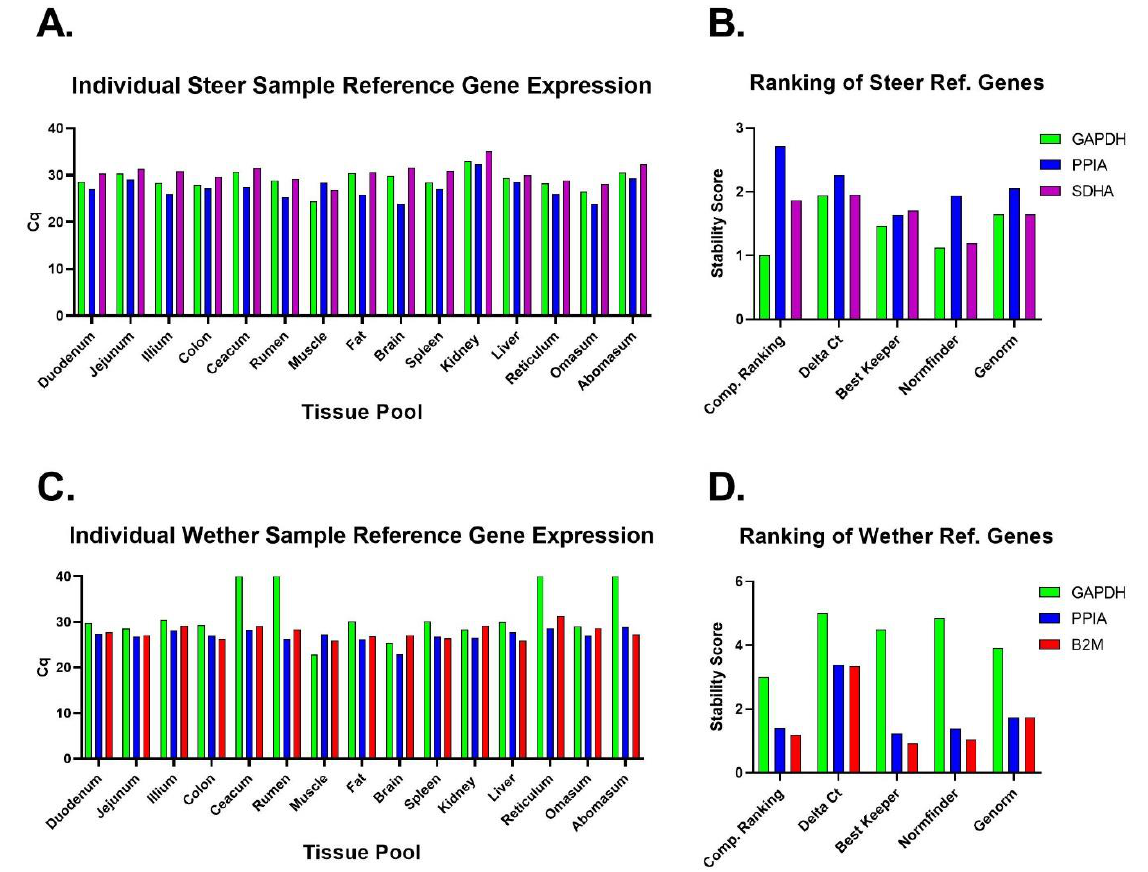
Figure A2. Reference Gene Stability Assessment Across Steer and Wether Samples. Average of technical replicates and stability score ranking of reference genes GAPDH, PPIA, B2M and SDHA in ( A , B ). Steers and ( C , D ). Wethers.